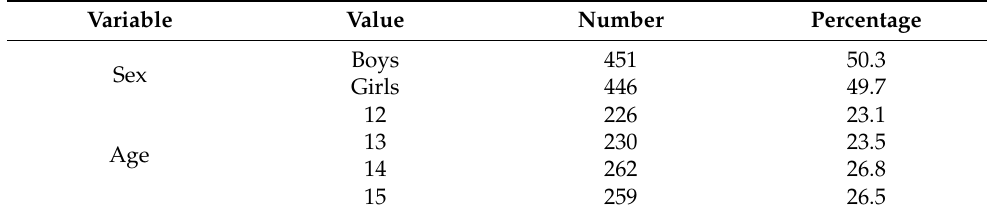
Table 1. Descriptive data of the sample (N =